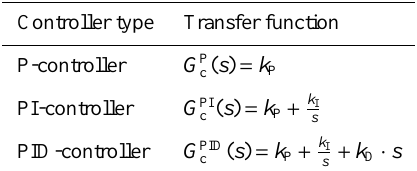
Table 3. Transfer functions of basic linear standard controller types (Datta et al.,